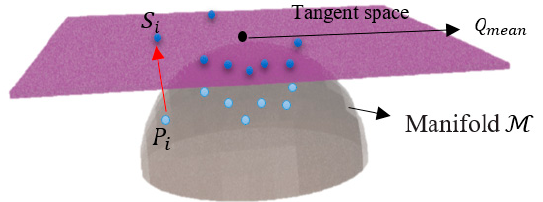
Figure 3. Graphic example of tangent space mapping, whereby the red arrow represents the exponential mapping of S i .